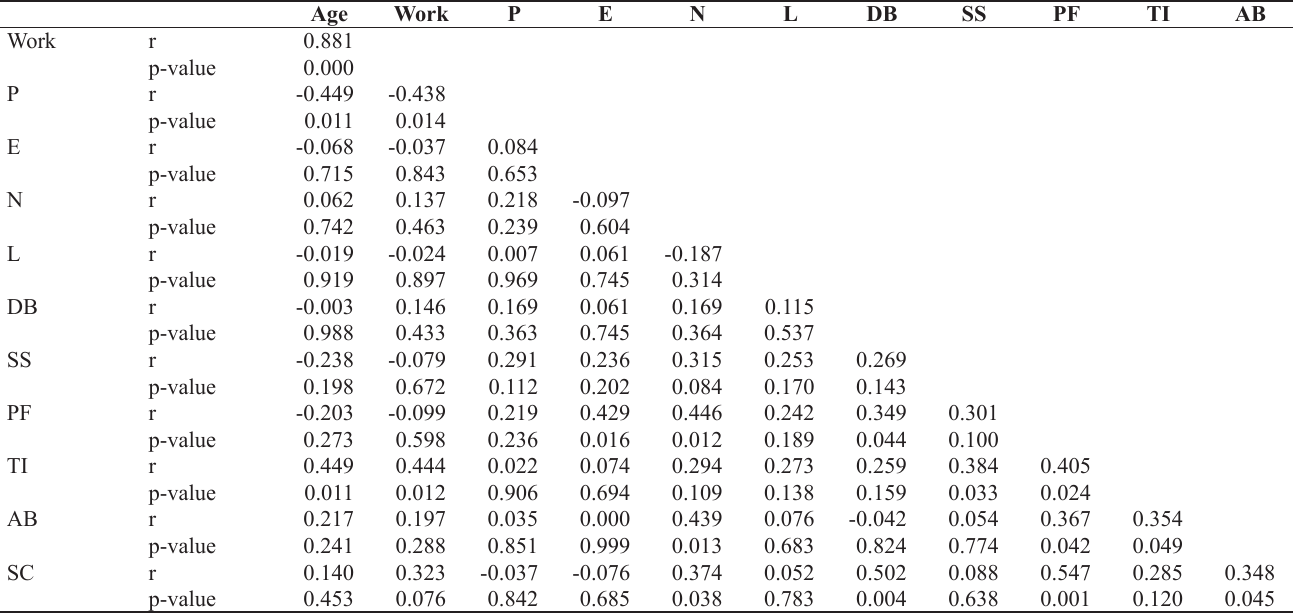
Table 2. Pearson correlation coefficient “r” and personality traits, age, working time as coach and leadership characteristics.